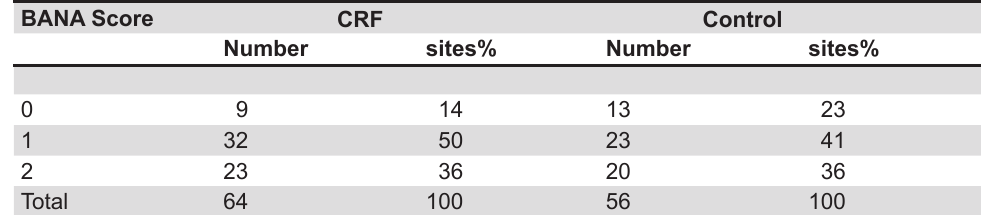
CRF= chronic renal failure. * positive correlation in both groups. ** negative correlation in some areas of the CRF group. NS= Not significant in both groups. Table 4- BANA test scores in chronic renal failure (CRF) and control groups